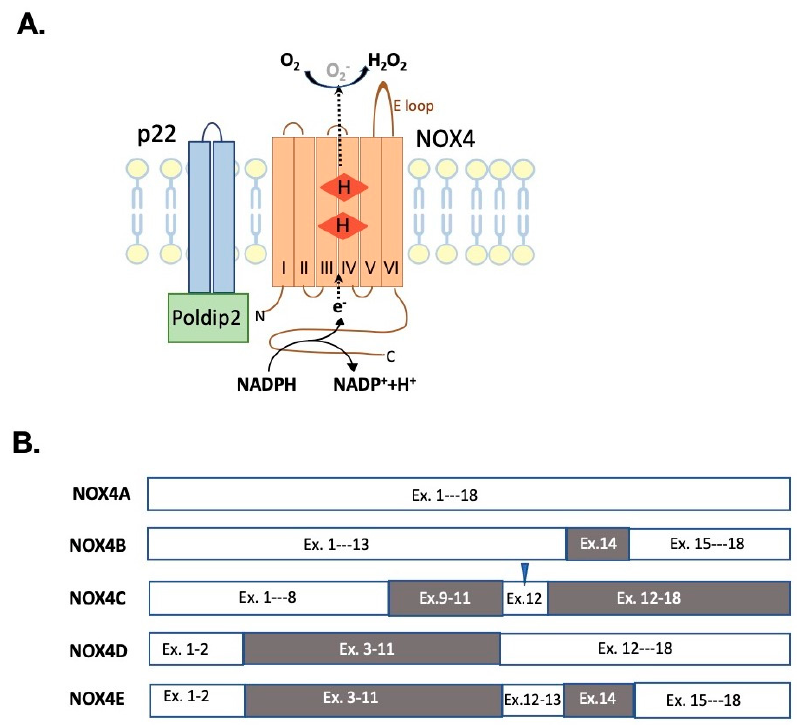
Figure 3. ( A ) Structure of NOX4. NOX4 is comprised from six membrane-spanning alpha-helices (I–VI) connected by five loops (A–E) and an intracytoplasmic tail that contains binding sites for FAD (not shown) and NADPH. Two heme molecules (H in red box) are anchored to four histidine residues in helices III and V, allowing electron transport to oxygen molecules. H 2 O 2 production takes place in the E loop. The protein p22 supports the stabilization of NOX4, while Poldip2 associates with p22 and contributes to the activation of NOX4 [92,93]. ( B ) NOX4 transcript variants [94]. Ex. = exon, the numbers refer to the numeration of exons. Empty box: exons present in the mRNA variant. Shaded boxes: missing exons from the mRNA variant. Triangle: early STOP codon.